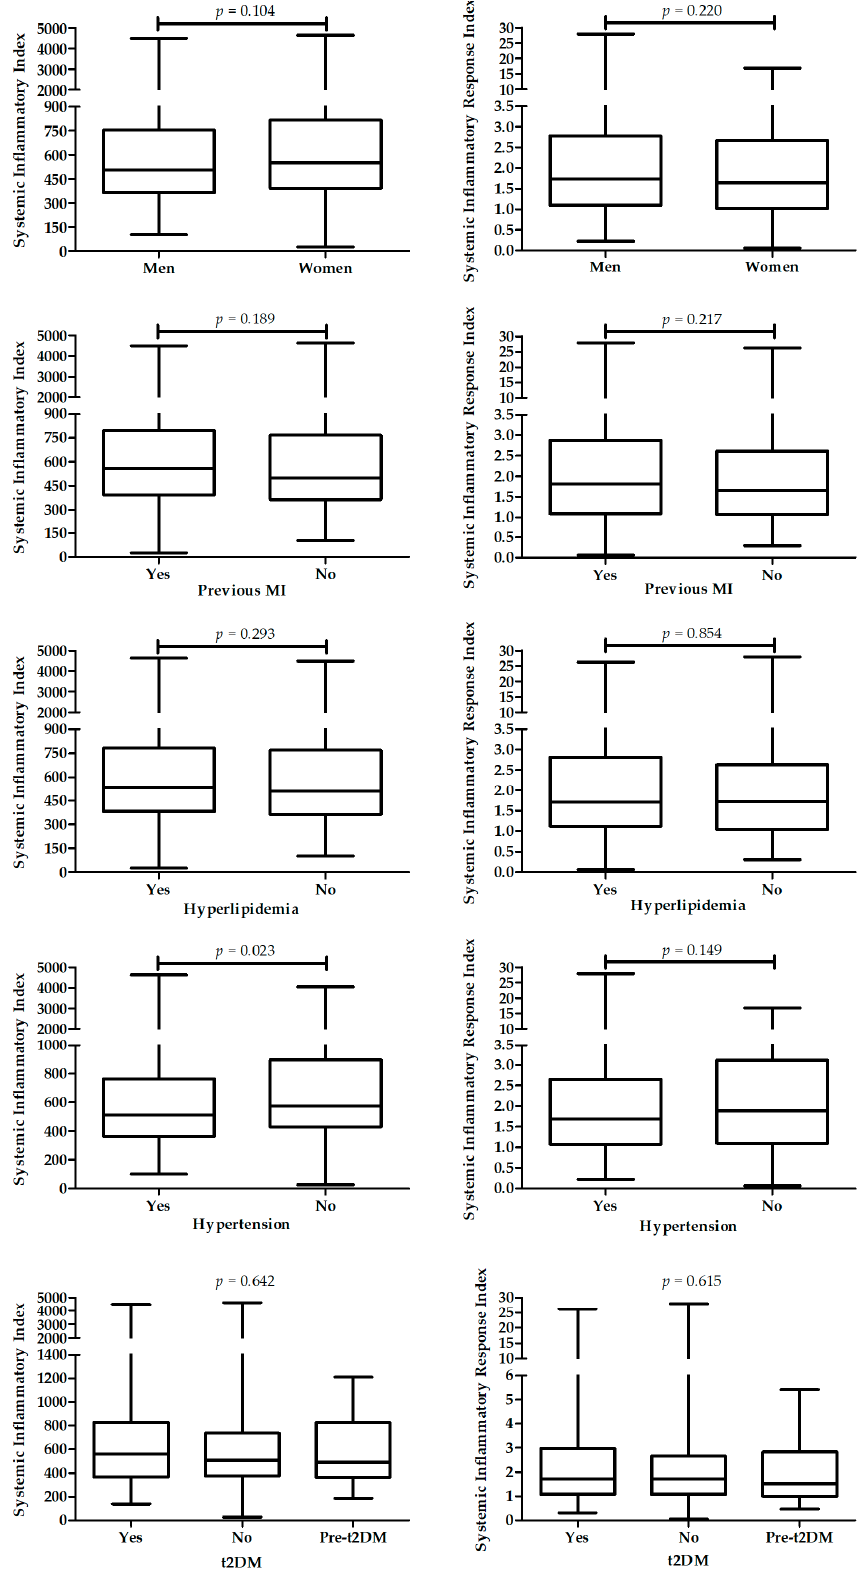
Figure 7. Differences in SII ( left panel) and SIRI ( right panel) between patients with different diag- nosis.